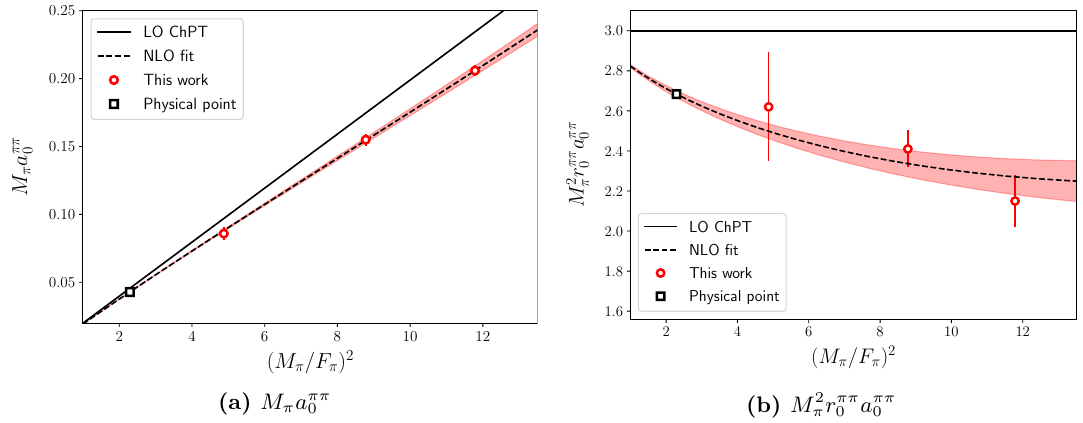
Figure 5. Chiral fits of the threshold parameters of the isospin-2 ππ system. Solid lines correspond to the LO ChPT predictions, which have no free parameters. The dashed line is a NLO fit to eqs. (3.15) and (3.16). We also include the 1 σ region as a shaded area. Circles mark our data points, while squares denote the extrapolated values at the physical